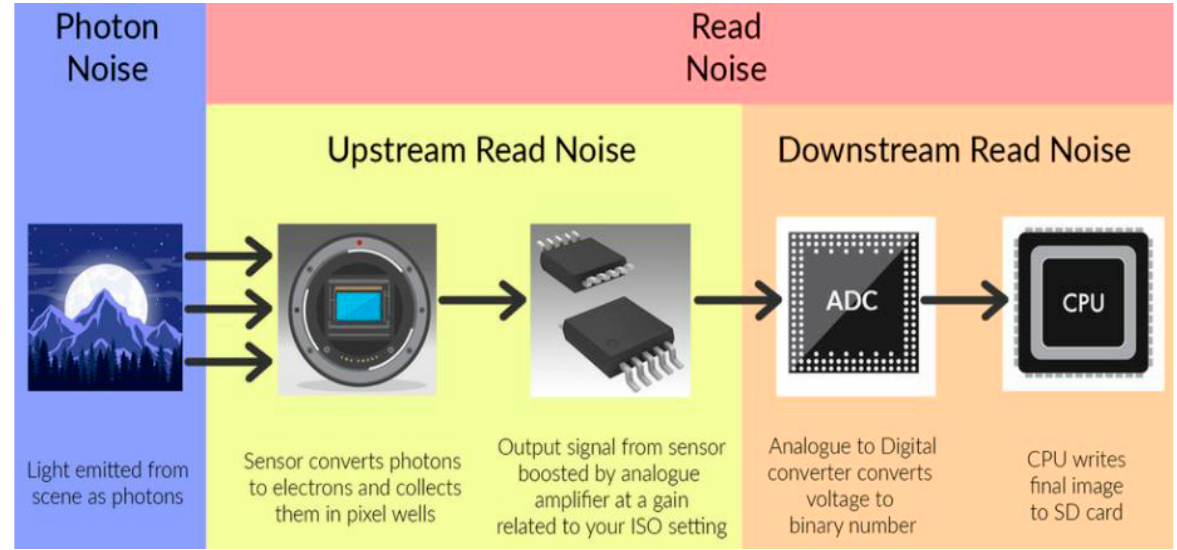
Figure 11. Illustration of a digital image with a Sony CMOS ISO invariant camera.